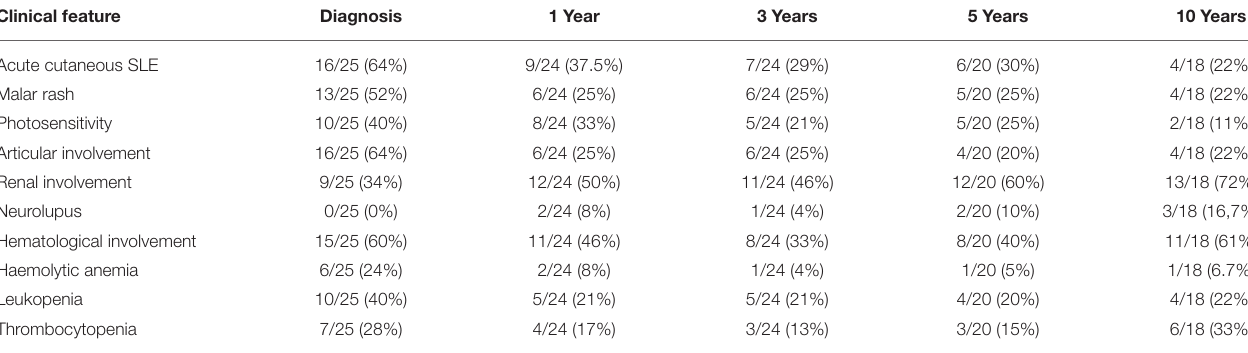
TABLE 1 | Evolution of clinical profile during